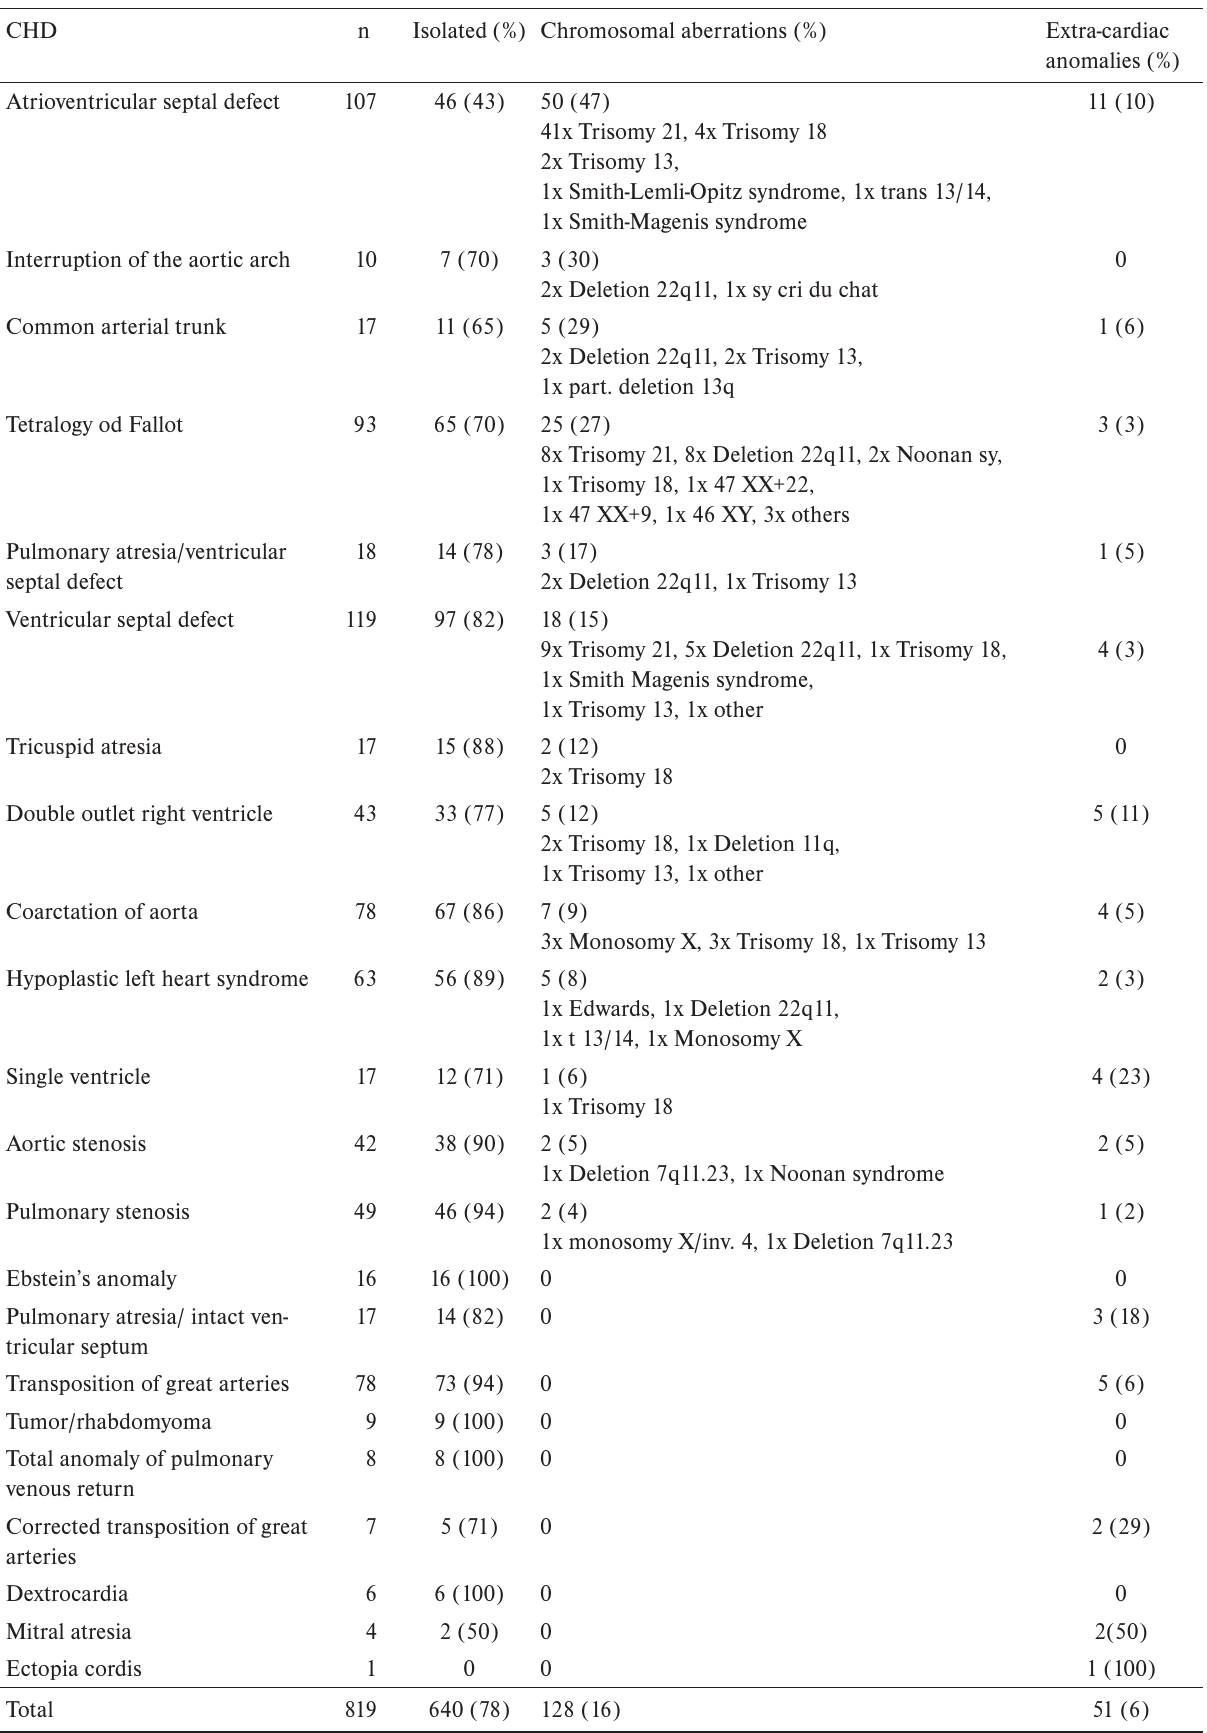
Table 1. Association of CHDs and genetic and morphological impairments from 1999–2017, divided according to the share of chromosomal aberrations.